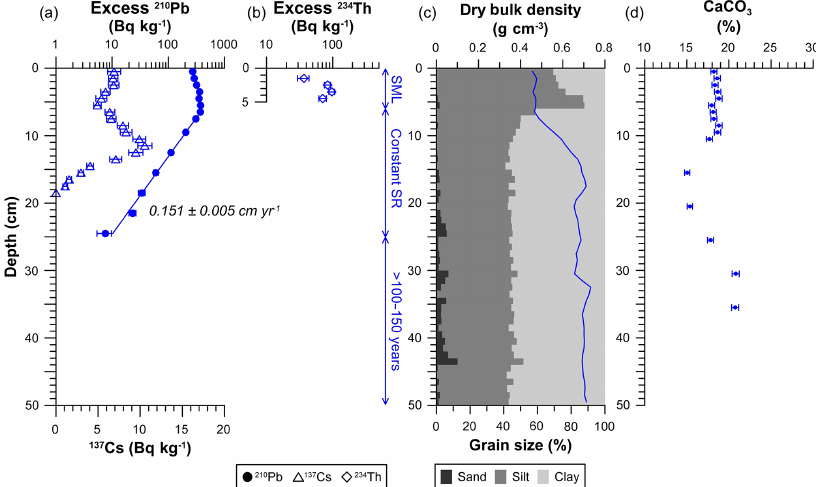
Figure 2. Sedimentological and geochemical characteristics of the untrawled sediment core. (a) Concentration profiles of excess 210 Pb (circles), indicating the average sedimentation rate below the upper 6cm, and 137 Cs (triangles). (b) Concentration profile of excess 234 Th in the upper 5cm. (c) Dry bulk density and grain size. (d) CaCO 3 concentration profile. The analytical error is given in horizontal error bars. Vertical scales indicate the process that has occurred in the depth range given. SML: surface mixed layer; SR: sedimentation rate.